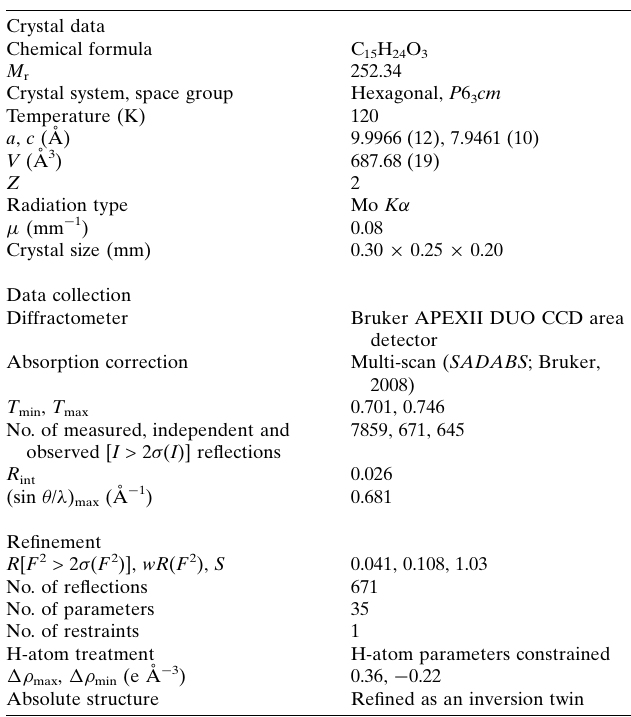
Table 1 Hydrogen-bond geometry (A˚ , (cid:2) ).